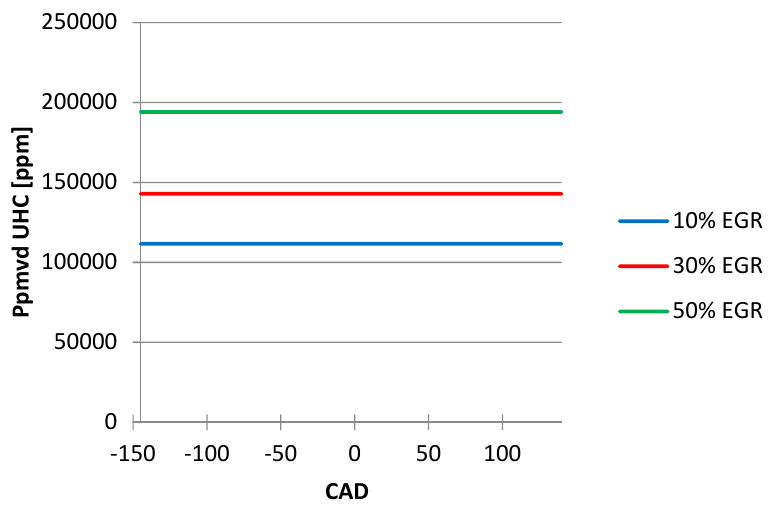
Figure 8. EGR ratio influence on UHC emissions.